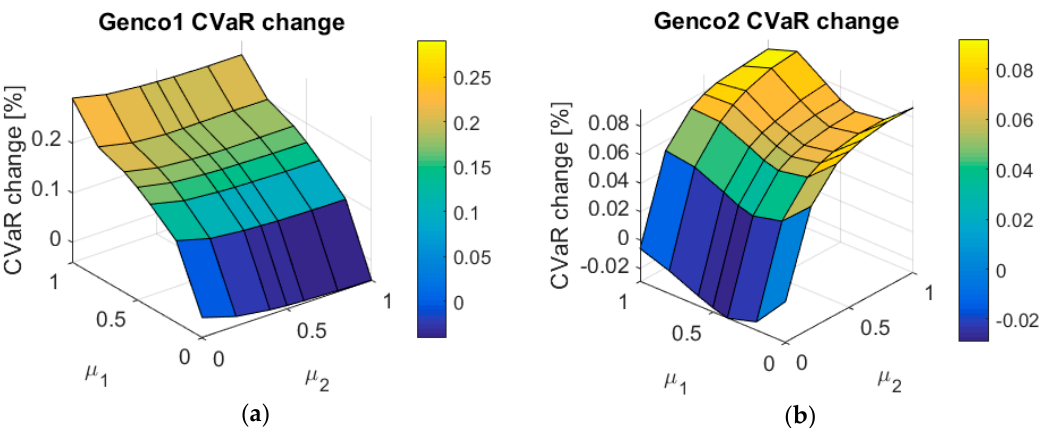
Figure 8. CVaR value relative change for Genco1 ( a ) and Genco2 ( b ).